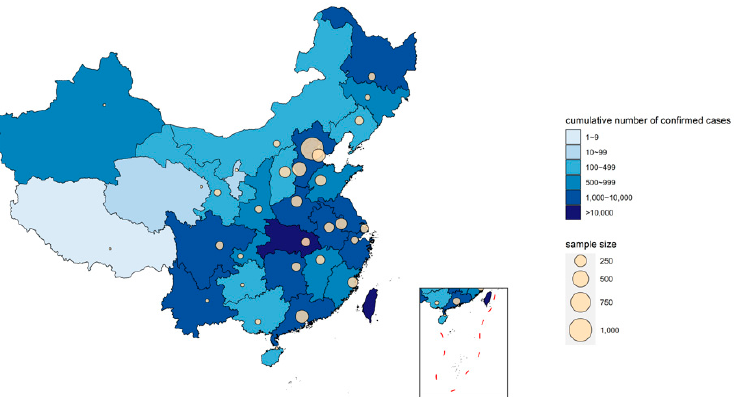
Figure 1. Geographical distribution of participants in the study. The color of the map indicates the cumulative number of confirmed cases in each province by the end of August 2021, according to the report from the Chinese Disease and Control Center [28]. Bubble size is proportional to the sample size of every investigation point.